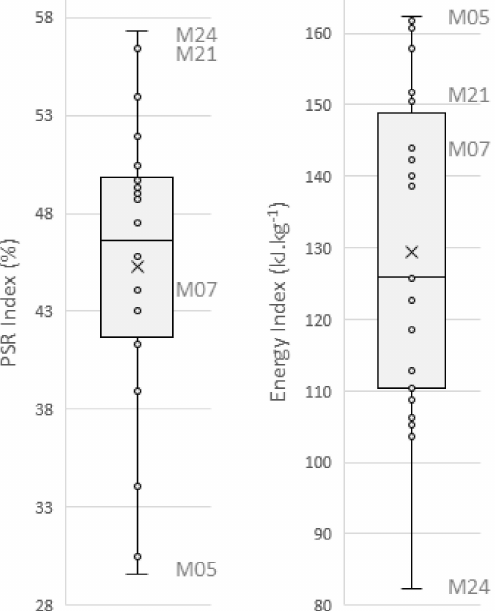
Figure 6. PSR index values (%) and Energy Index (kJ.kg − 1 ) for 24 lines of inbred